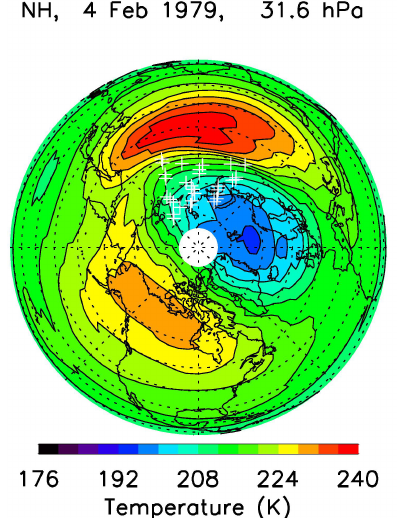
Figure 8. V6 temperatures at 31.6hPa and the locations of spuri- ous PSC effects or “false positives” (white plus signs) for 4 Febru- ary